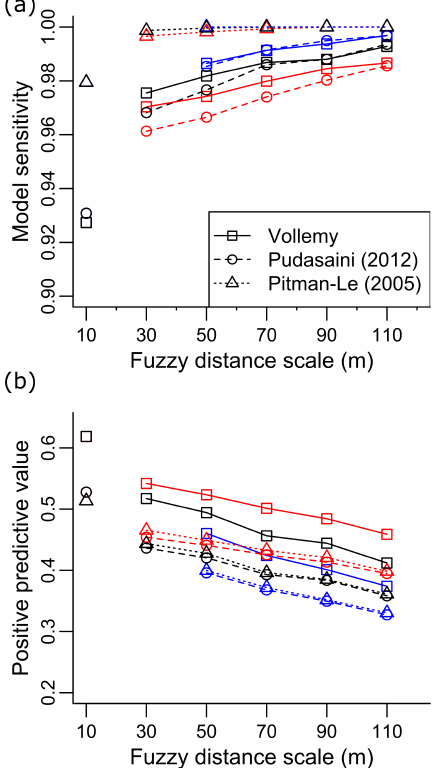
Figure 7. Fuzzy performance metrics at 3-cell (30m), 5-cell (50m), 7-cell (70m), 9-cell (90m), and 11-cell (110m) length scales ( λ ) and fuzzy quantities of 0.1 (blue), 0.25 (black), and 0.5 (red) for (a) model sensitivity and (b) positive predictive value for Voellmy– Salm (solid line), Pudasaini (2012) (dashed line), and Pitman and Le (2005) (dotted line) flow